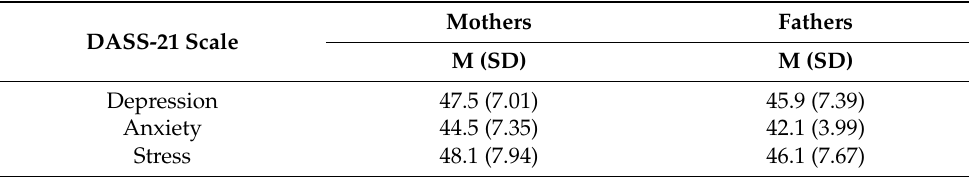
Table 6. Mean (M) and Standard Deviation (SD) values in the DASS-21 scales of parents at T1. DASS-21